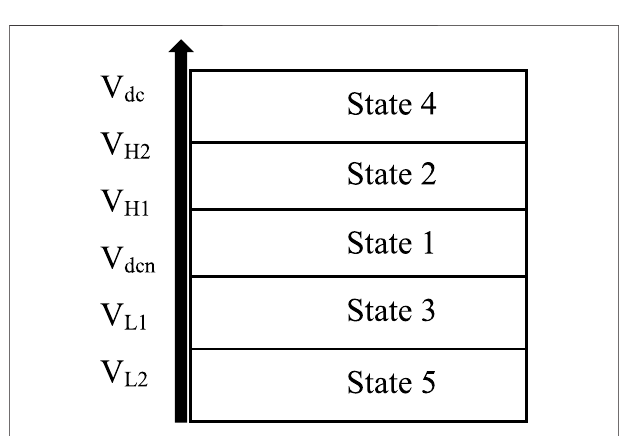
FIGURE 5 | Operation regions of DC bus